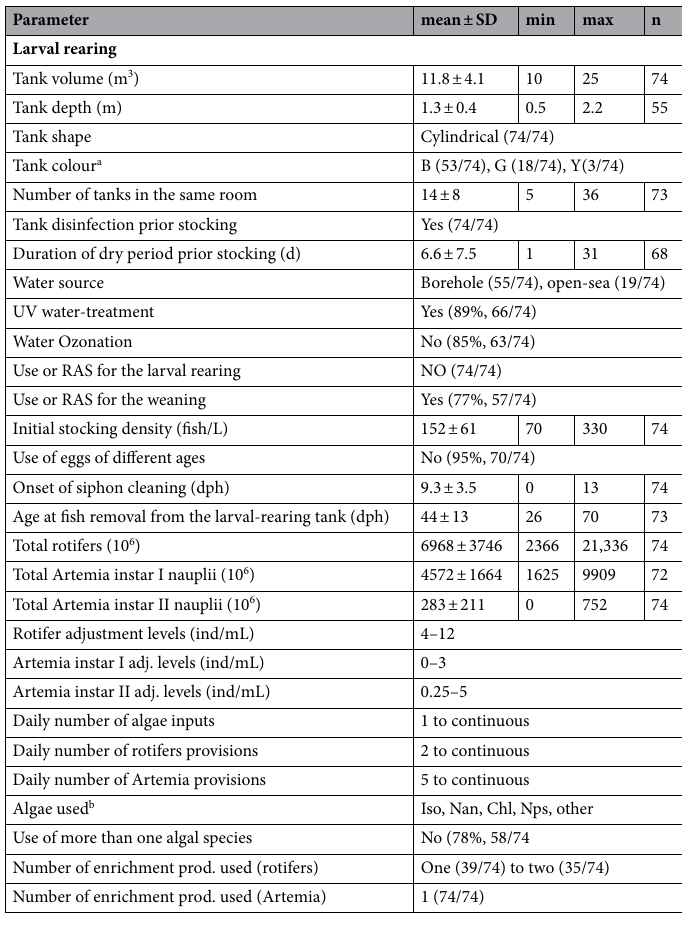
Table 2. Range of the main rearing parameters during the larval-rearing period. For the rest abiotic and nutritional parameters, see also Figs. 1, 2, S1. a B black, G green, Y yellow. b Iso Isochrysis galbana ; Nan Nannochloris atomus ; Chl Chlorella minutissima ; Nps Nannochloropsis